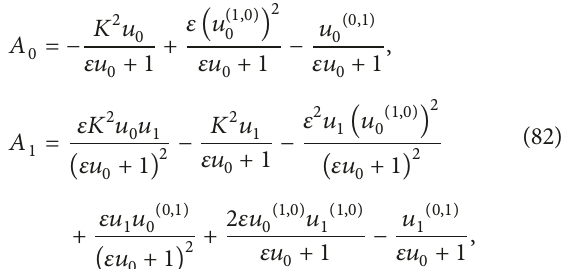
homogeneous partial differential equation of the engineering